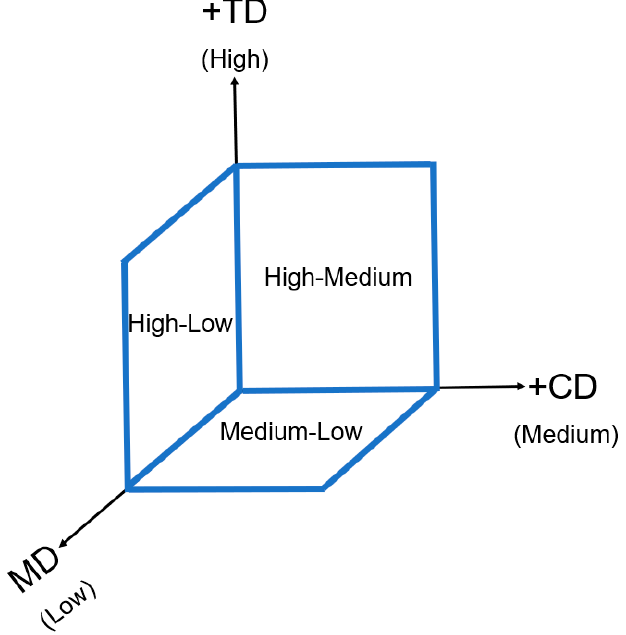
Figure 13. Projected fibre